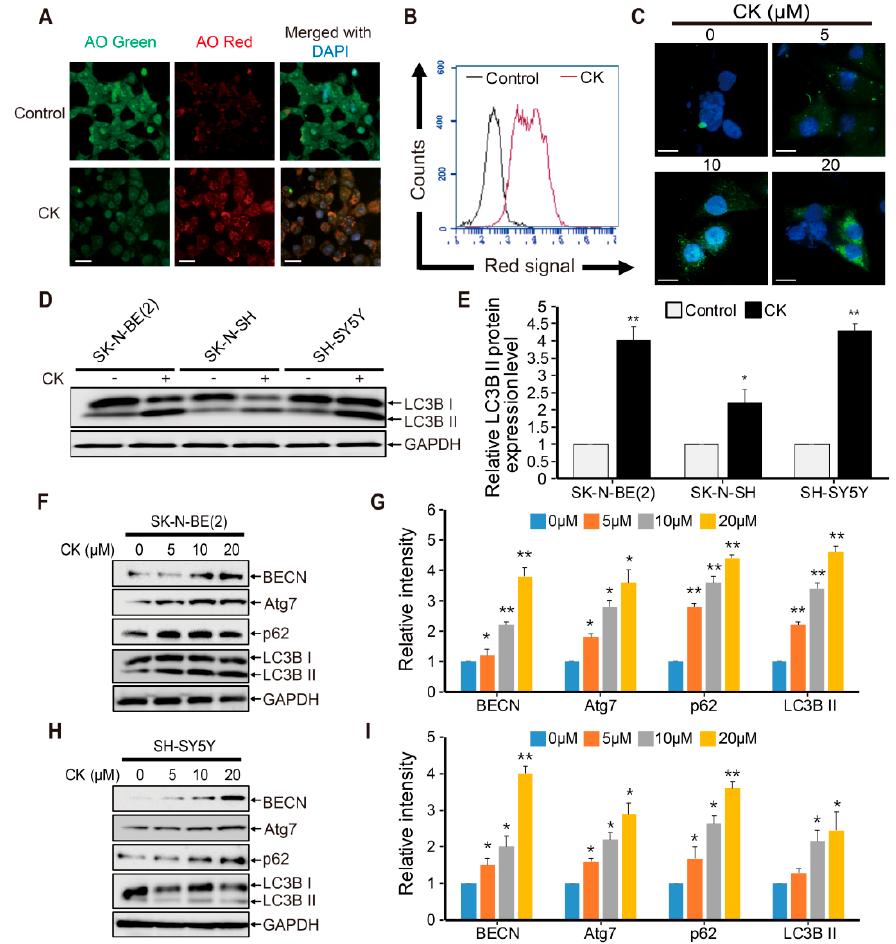
Figure 5. CK treatment promotes early stage autophagy but blocks autophagic flux. ( A ) Acidic vesicular organelles (AVOs) were examined by incubating SK-N-BE(2) cells treated with or without CK in 10 µ M acridine orange (AO) for 30 min, and images were captured using a fluorescence microscopy. ( B ) AVO-positive SK-N-BE(2) cells were quantified by flow cytometry. Results shown are representative of three independent experiments. ( C ) pEGFP-LC3B transfected stable SK-N-BE(2) cells were treated with different concentrations of CK for 12 h, and images showing LC3-GFP puncta and accumulation of autophagosomes were visualized under a florescence microscope. CK treatment increases GFP-LC3 punctuation. Scale bar: 50 µm. ( D ) The LC3B expression level was measured by western blot in SK-N-BE(2), SK-N-SH, and SH-SY5Y cells treated with 5 µM of CK for 24 h. ( E ) The relative LC3B II protein expression level was significantly increased by CK treatment in all three neuroblastoma cell lines. ( F – I ) Cells were treated with various concentrations of CK for 24h in SK-N-BE(2) and SH-SY5Y cells. Western blotting was performed with antibodies specific for BECN, Atg7, p62, LC3B, and GAPDH in SK-N-BE(2) cells ( F ) and SH-SY5Y cells ( H ). Relative protein expression levels were shown in the histogram ( G,I ), and band intensities were quantified using the Image J program. All bar graph data ( E , G , I ) are shown as mean ± SD in three independent experiments. *: p < 0.05 versus control and **: p < 0.01 versus control.